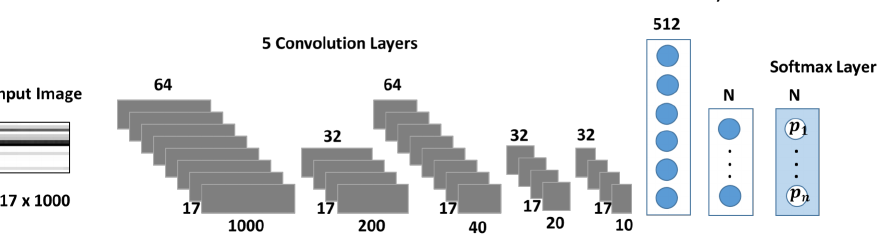
Figure 4. Proposed CNN model. The input image is grayscale with a size of ( 17,1000 ) since there are 17 sequences of sensory data. The first and third convolution layer contain 64 filters per layer while the other three layers contain 32 filters per layer. The size of the constructed images by filters in each layer is shown below each layer. The filter size is [ 1,5 ] in the first three convolution layers, and [ 1,2 ] for the last two layers. Padding is same after first convolution layer and stride is [ 1,1 ] . Stride is [ 1,5 ] in second and third convolution layers, while it is [ 1,2 ] in fourth and last layers. Two fully connected (FC) layers, one with 512 neurons and the second one has a size according to the number of target classes. Finally, there is a softmax layer to predict